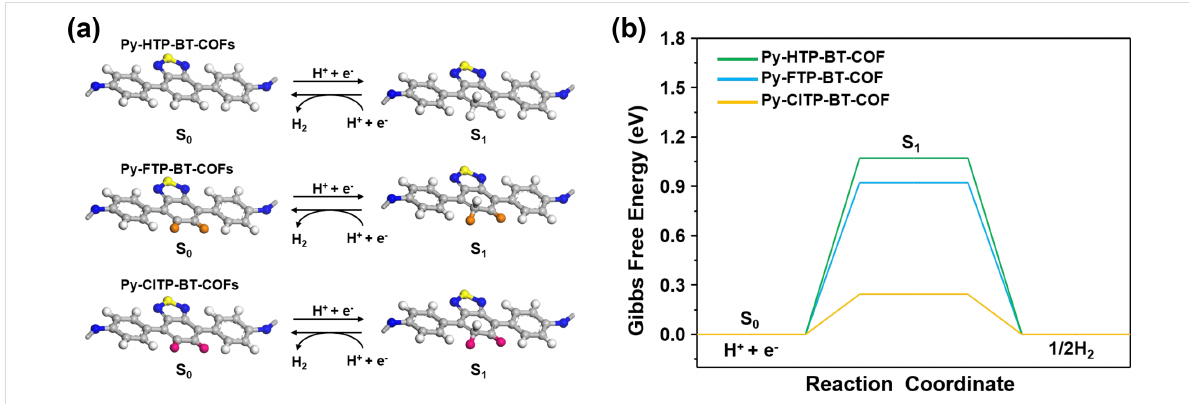
Figure 7: (a) Proposed reaction pathway for H 2 evolution (single-site reaction) on the halogen-substituted carbon atom of P42 – P44 (grey: C; white: H; yellow: S; blue: N; orange: F; pink: Cl). (b) Free-energy diagrams for H 2 evolution via a single-site reaction pathway at 0 V vs RHE on the halogen- substituted carbon atom of COFs. Reproduced from [67]. Copyright © 2020 Wiley-VCH GmbH. Used with permission from Chen et al., Modulating Benzothiadiazole-Based Covalent Organic Frameworks via Halogenation for Enhanced Photocatalytic Water Splitting, Angew. Chem. Int. Ed., John Wiley and Sons. This content is not subject to CC BY